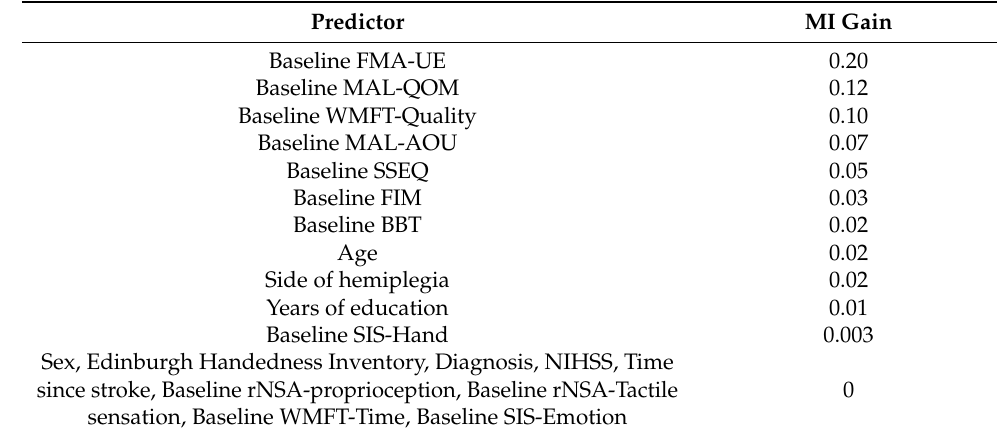
Table 2. Mutual information gain of the predictors, sorted by gain. Predictor